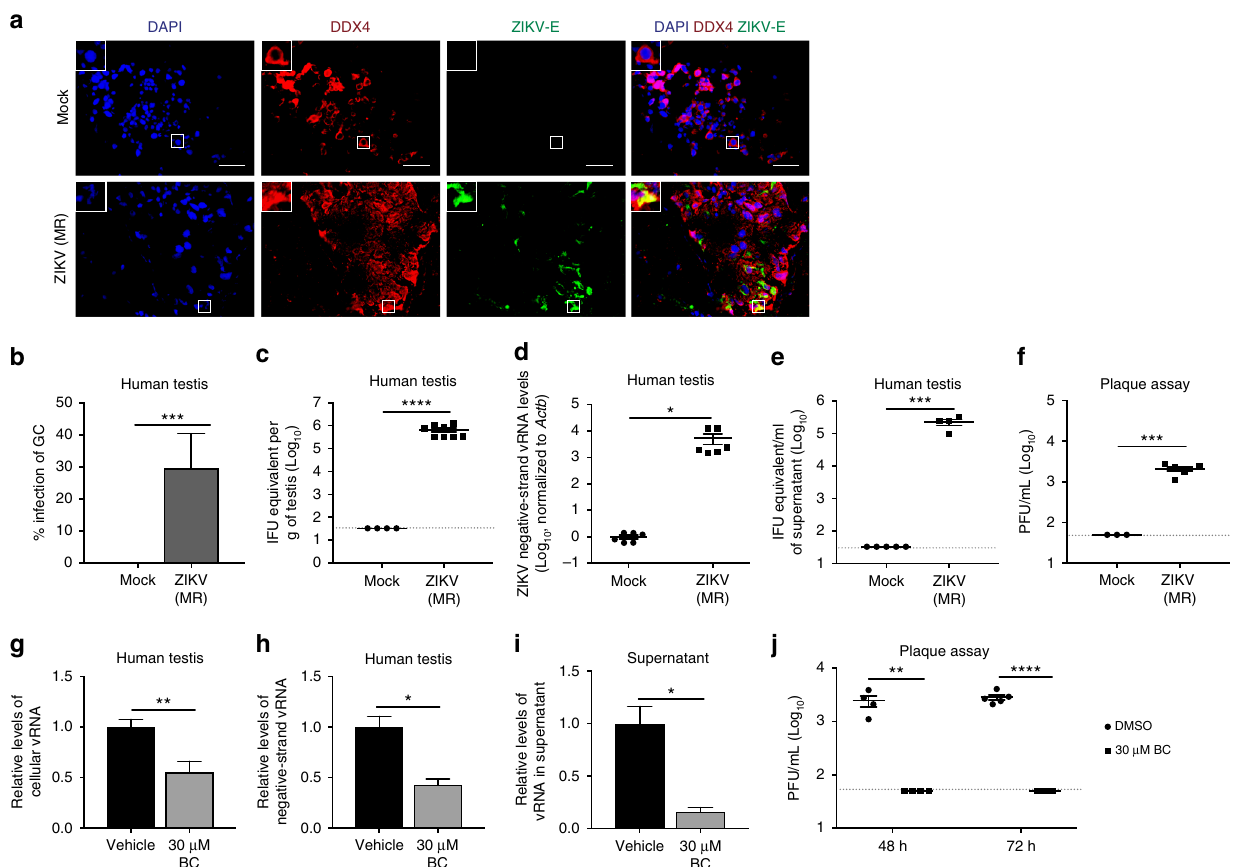
Fig. 6 ZIKV infects human male GCs and BC reduces ZIKV infection. a , b Mock-infected and ZIKV-infected (IFU = 1 × 10 7 ) human testis immunostaining with DDX4 and ZIKV-E ( a ) and quanti fi cation ( n = 4 for mock-infected and 7 for ZIKV-infected) ( b ) at 72 hpi. c – e qRT-PCR analysis of ZIKV cellular vRNA in human testis ( n = 4 for mock- and 8 for ZIKV-infected) ( c ), ZIKV negative-strand vRNA in human testis ( n = 6 for mock-infected and ZIKV-infected) ( d ), and ZIKV vRNA in human testis culture supernatant ( n = 5 for mock-infected and 4 for ZIKV-infected) ( e ) of mock-infected and ZIKV-infected (IFU = 1 × 10 7 ) human testis samples at 72 hpi. f Infectivity of supernatant from mock-infected and ZIKV-infected human testis as assessed with plaque assay using Huh-7.5 cells ( n = 4 for mock-infected and 6 for ZIKV-infected). g – i qRT-PCR analysis of ZIKV cellular vRNA in human testis ( g ), ZIKV negative- strand vRNA in human testis ( h ), and ZIKV vRNA in human testis culture supernatant ( i ) of BC-treated and DMSO-treated ZIKV-infected human testis samples. j Infectivity of supernatant from BC-treated and DMSO-treated ZIKV-infected human testis as assessed with plaque assay using Huh − 7.5 cells ( n = 4 for DMSO and BC for 48 h and n = 6 for DMSO and BC for 72 h). Statistical values are presented as mean ± s.e.m. and analyzed by two-sided t test, * p ≤ 0.05, ** p ≤ 0.01, ***p ≤ 0.001, **** p ≤ 0.0001. Scale bar, 50 μ m. ZIKV strain is MR 766 Methods Experimental design . Required samples sizes were estimated using the results of preliminary experiments. Based on the methods for data collection in these experiments, blinding and randomization were not required. All samples and animals used in this study were included in the analysis. Cells and viruses . Male GCs were derived from an adult 12-month-old wild-type mice on a mixed C57Bl6/Sv129 background (Regeneron Pharmaceuticals) and